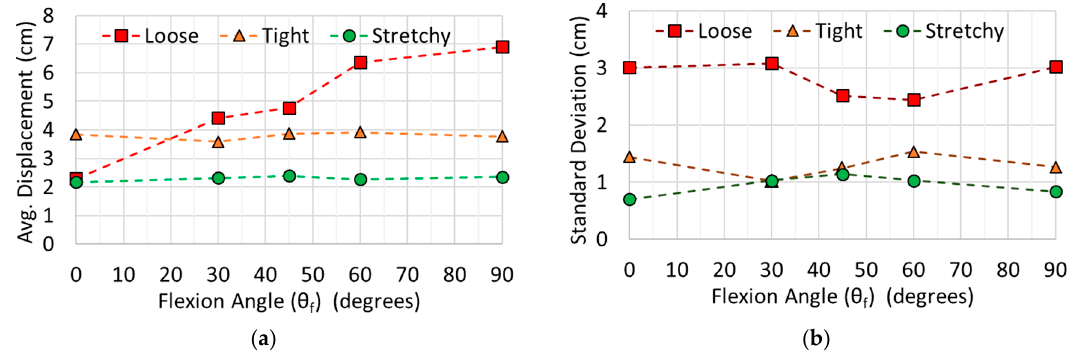
Figure 5. ( a ) Total average displacement, and ( b ) standard deviation (for all nine markers and in both X and Y directions) as a function of flexion angle ( θ f ) for all three types of sleeves.